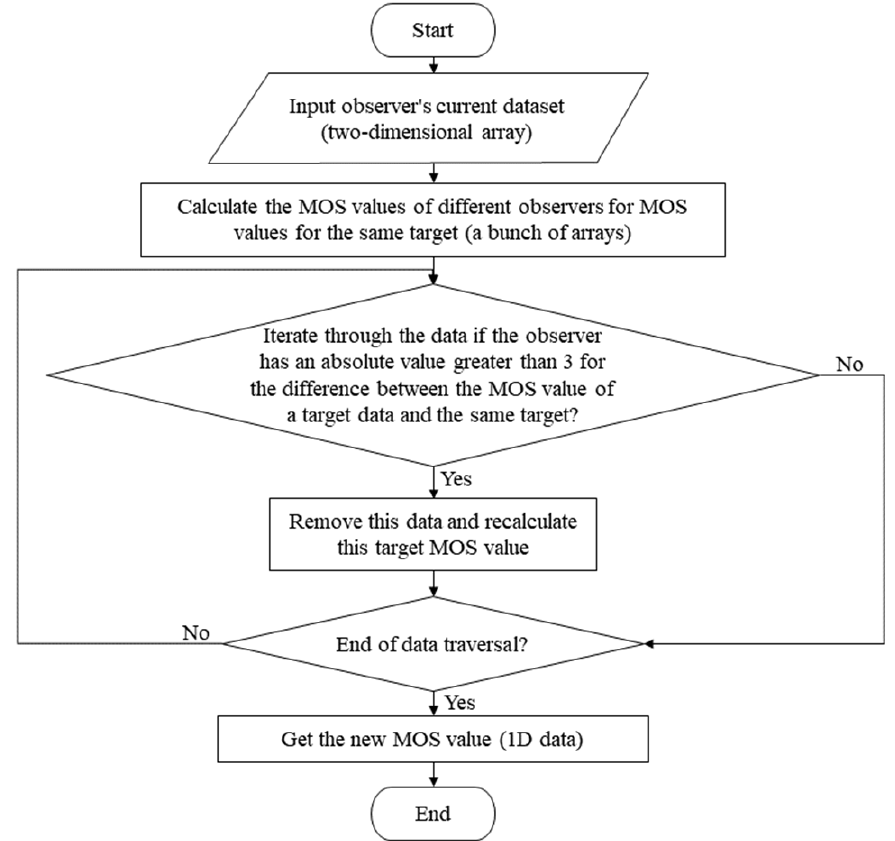
Figure 8. Compilation framework for the subjective scaling algorithm.